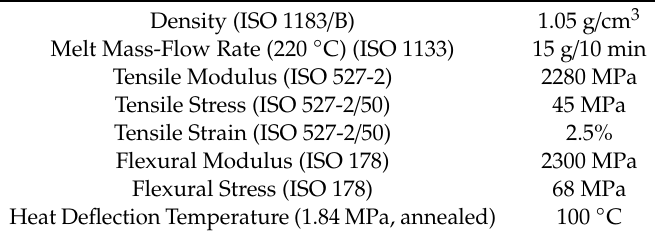
Table 1. Acrylonitrile butadiene styrene ABS properties.